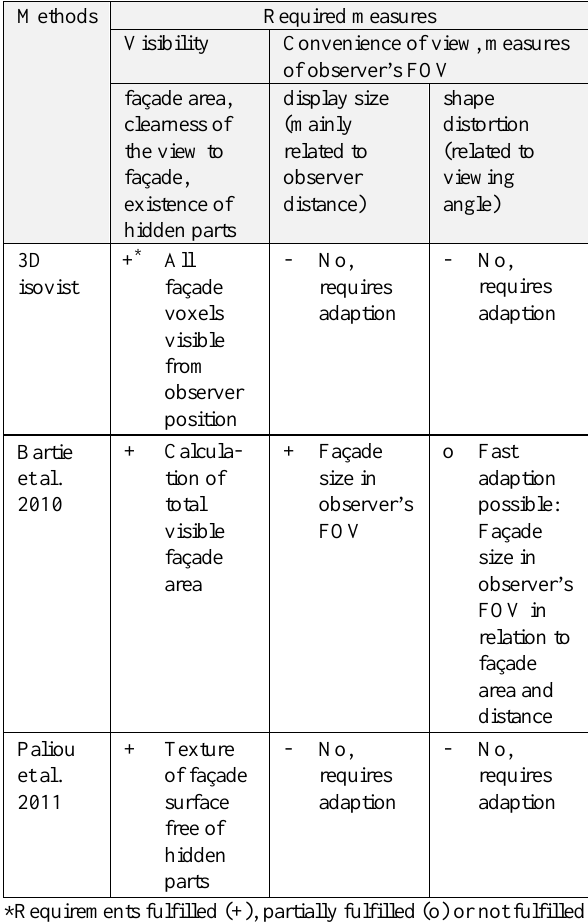
Table 1: Comparison of scenario requirements to visibility analysis